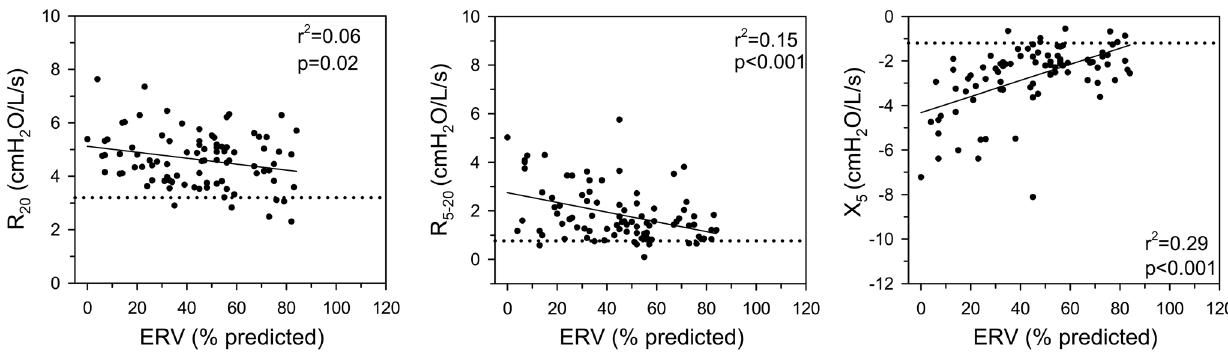
Figure 3. Individual values for R 20 , R 5 2 20 , and X 5 are related to ERV. Dotted line represents the upper limit of normal for each parameter. following bronchodilator administration (1.72 6 0.14 vs. 1.12 6 0.09